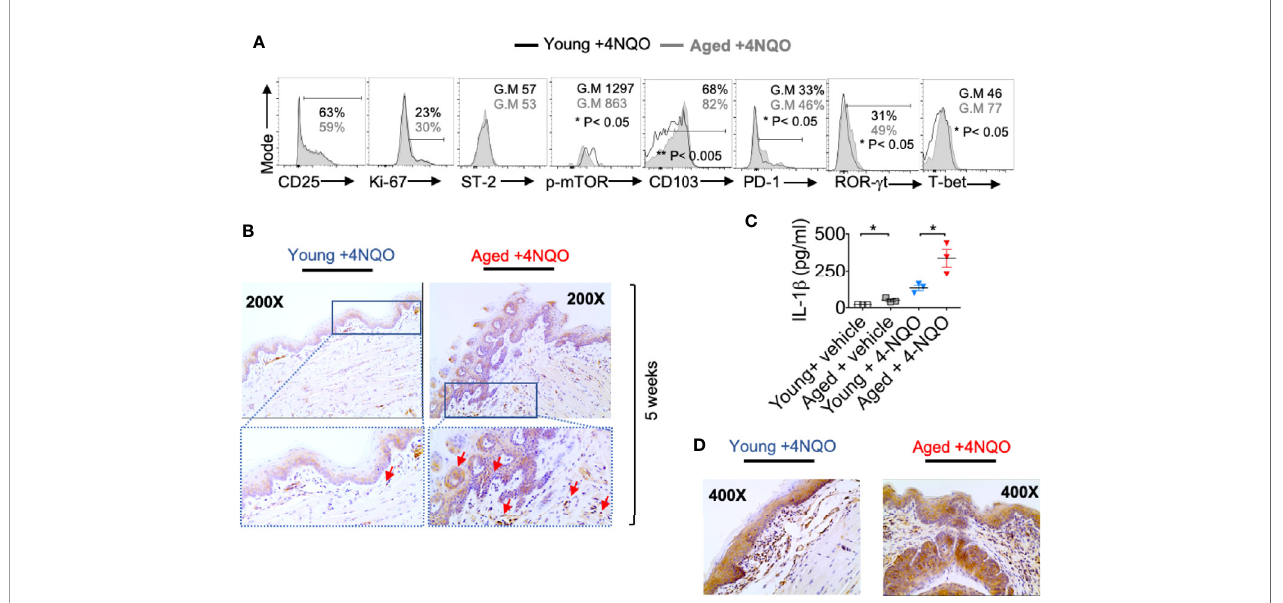
FIGURE 3 | Aged mice have distinct T reg phenotype and elevated levels of IL-1 b compared to young mice. 16 weeks after 4-NQO administration, single-cell suspension from tongue was re-stimulated with PMA/Ionomycin for 4 hours. Flow cytometry histograms showing indicated protein expression in CD45 + CD3 + CD4 + Foxp3 + cells (A) . Tongue tissues were processed for IL-1 b immuno-histochemical staining at 5 weeks (B) . Supernatants collected at 12 weeks were processed for IL-1 b ELISA. Mean +/- SEM in 3 mice/group (Mann-Whitney test *P< 0.05) (C) . Tongue tissues were processed for IL-1 b immuno-histochemical staining at 24 weeks (D) .